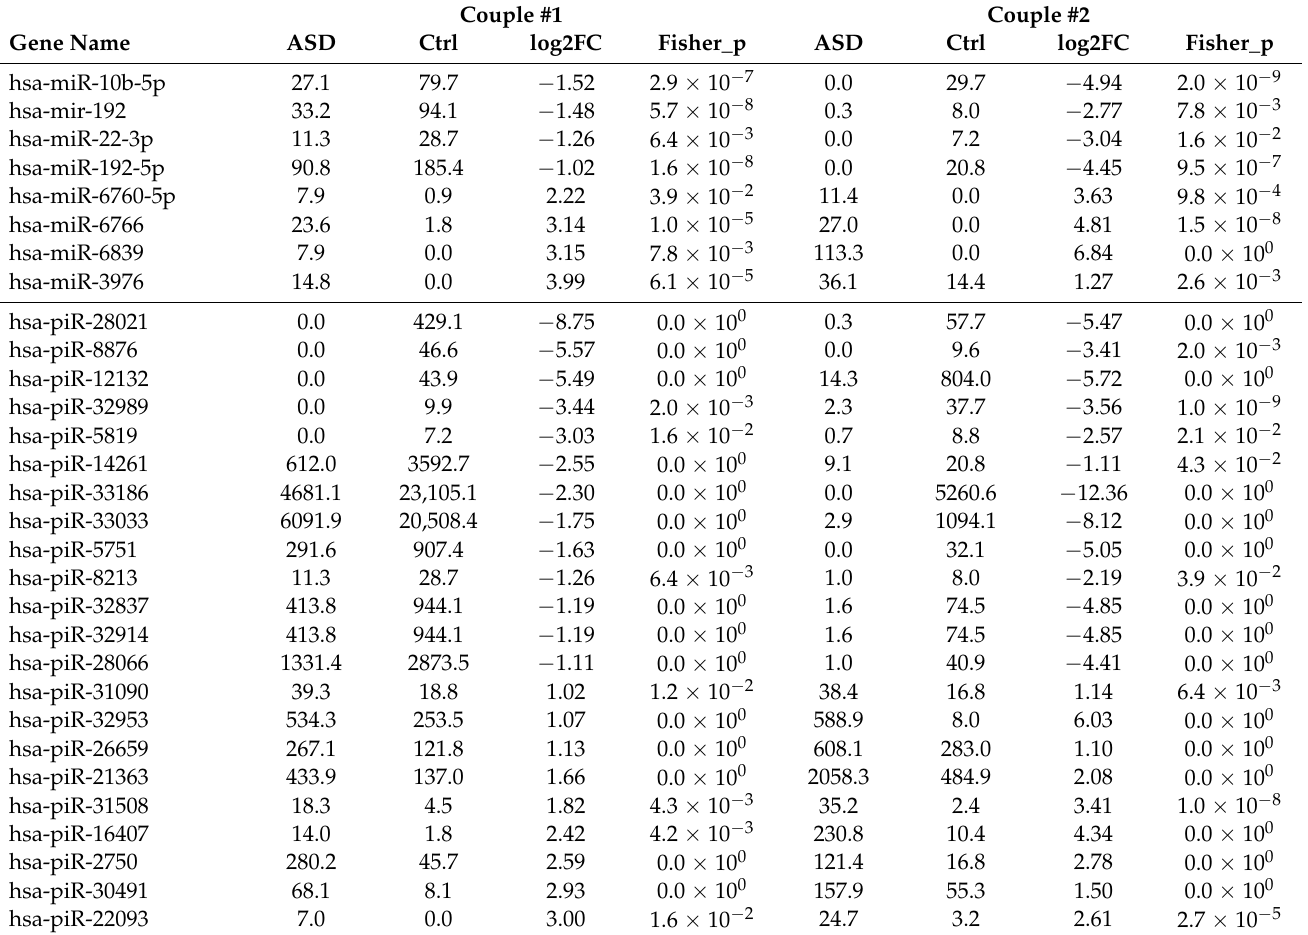
Table 3. MiRNAs and piRNAs common to the couples #1 and #2. log2FC, log2 fold change;